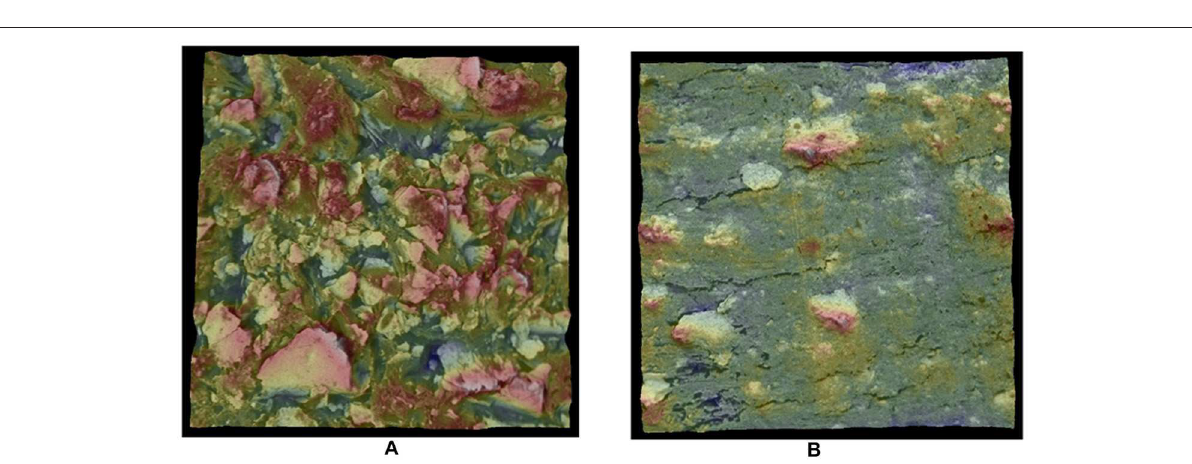
Frontiers in Materials |